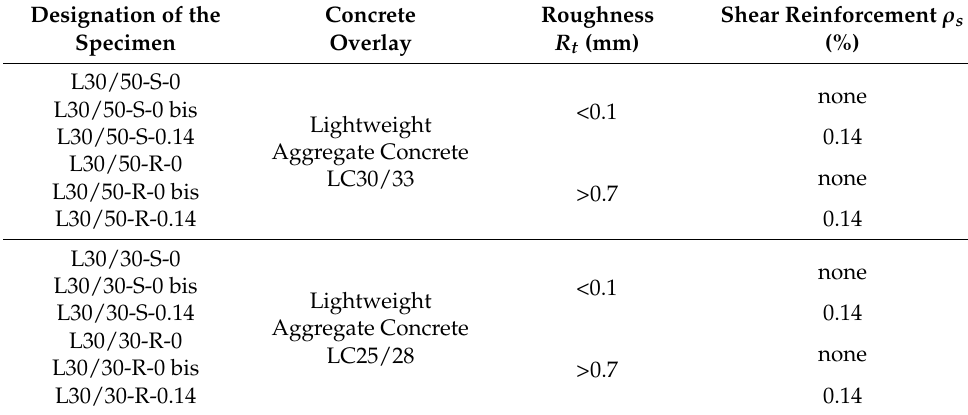
Figure 4. View of the specimen: ( a ) In the test setup before start of the test, ( b ) during measurements of the surface deformations by DIC, ( c ) detail of the surface pattern with computational mesh and bases for deformation measurements.